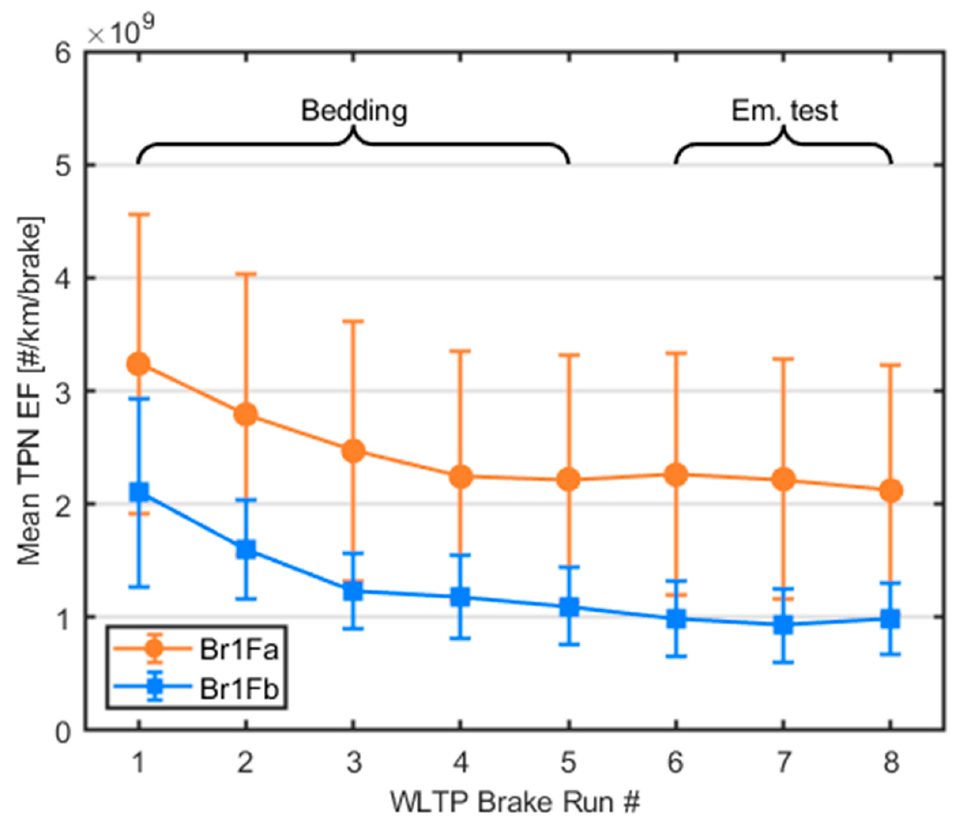
Figure 8. Overview of mean TPN emission level for repeated testing of WLTP-Brake cycle for Br1Fa (ECE pad) and Br1Fb (NAO pad) from all labs. The first five runs of the WLTP-Brake cycle correspond to the bedding of the friction pair. Runs 6–8 are the actual emission measurements. The error bars represent the standard deviation from all labs for each run, excluding the volatile particle emission measurements at Lab T for Br1Fa.